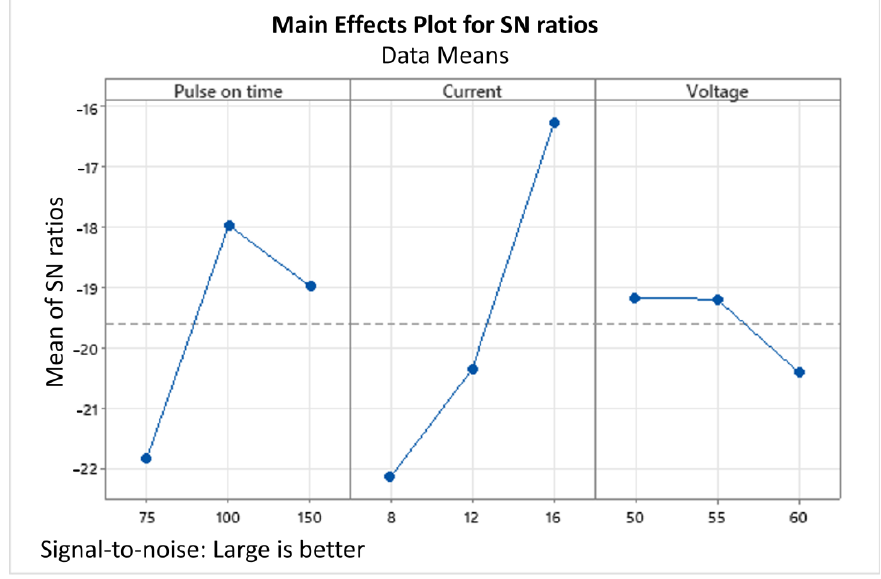
Figure 8. Main effects plot for S/N ratios (pulse-on time is in µs, current in amperes, and voltage in